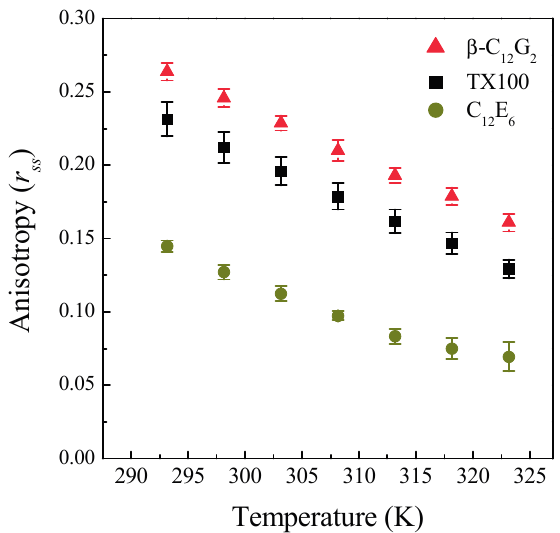
Figure 4. Steady-state fluorescence anisotropy, r ss , of C6 micellar solutions as a function of temperature.